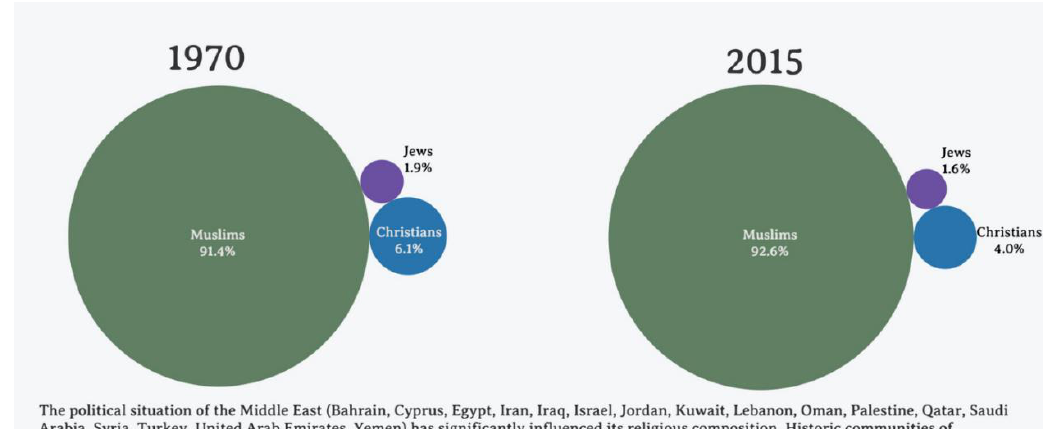
Figure 7. Religious diversity in East Africa, 1970 and 2015.